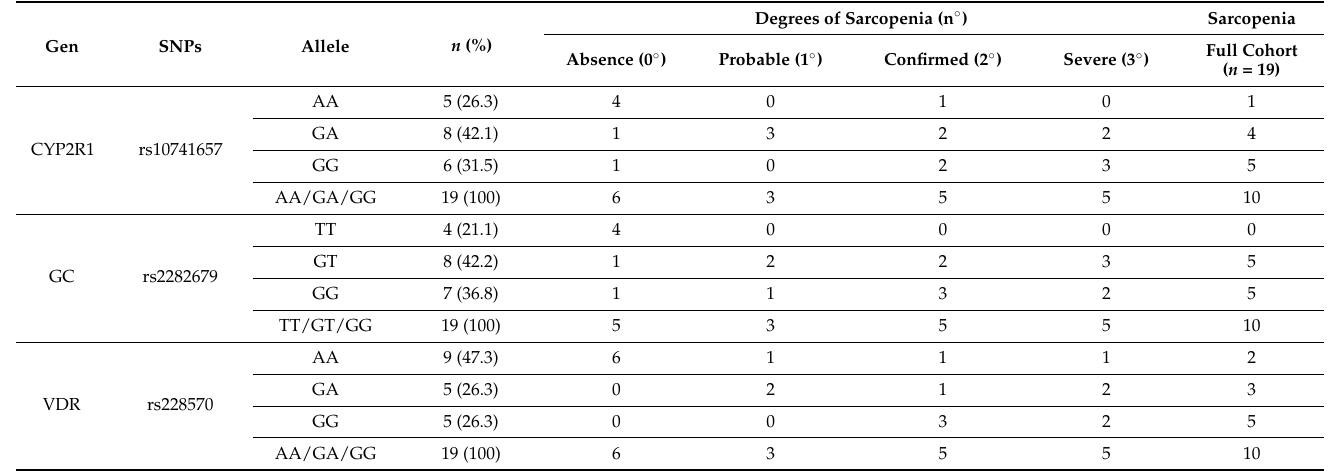
Table 3. Polymorphisms of genes, 25-hydroxy vitamin D concentration and degrees of sarcopenia of study participants.